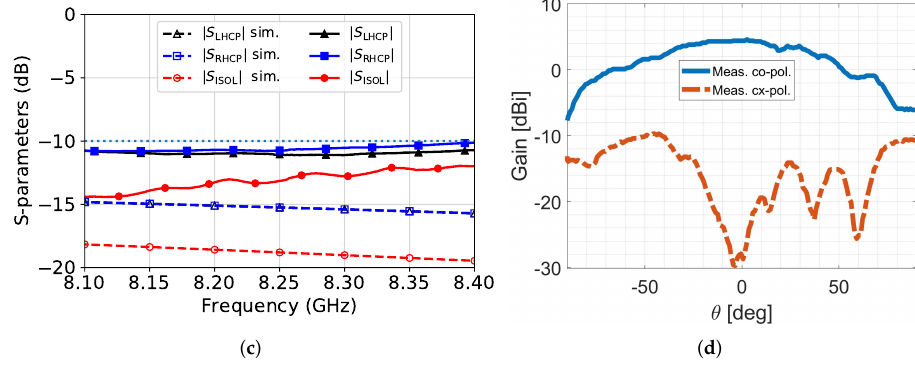
Figure 3. Simulated RHCP ( G R ) and LHCP ( G L ) gain patterns versus elevation angle with (filled markers) and without (empty markers) monopoles around the single radiating patch, for the cut-planes at ( a ) φ = 0 ◦ and at ( b ) φ = 90 ◦ . The results are provided at the central frequency f = 2.2 GHz. ( c ) Simulated (empty triangular/squared markers, dashed lines) and measured (filled triangular/squared markers, continuous lines) reflection coefficients at RHCP ( S RHCP ) and LHCP ( S LHCP ) input ports, together with simulated (empty circular markers, dashed line) and measured (filled circular markers, continuous line) isolation between RHCP and LHCP ports ( S ISOL ), in the considered bandwidth [ 8.1,8.4 ] GHz. ( d ) Measured co-polar and cross-polar gain patterns at φ = 0 ◦ versus elevation angle at the operating frequency f = 8.25 GHz.